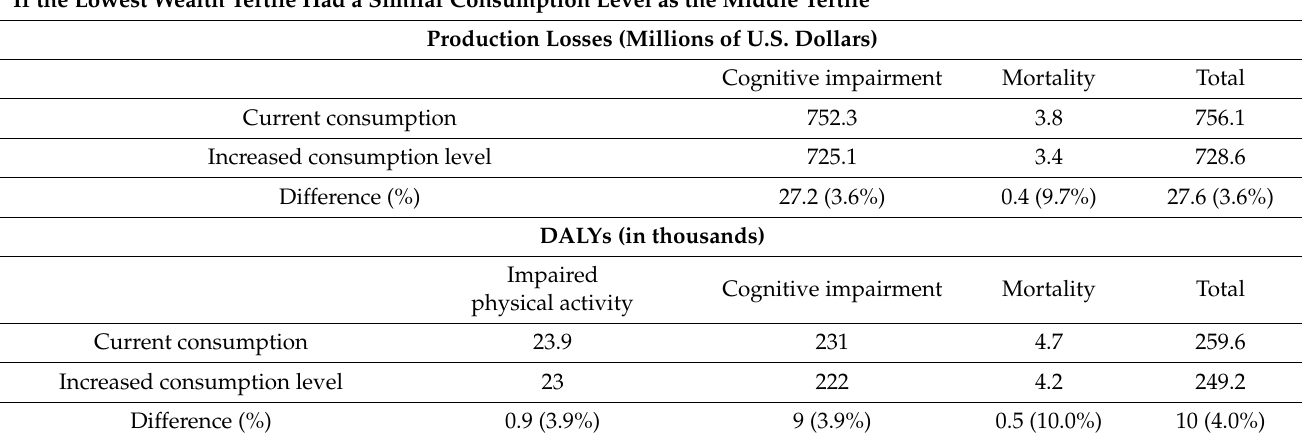
Table 4. Reduction in the burden of IDA if the lowest wealth tertile increased consumption and duration of consumption of fortified infant